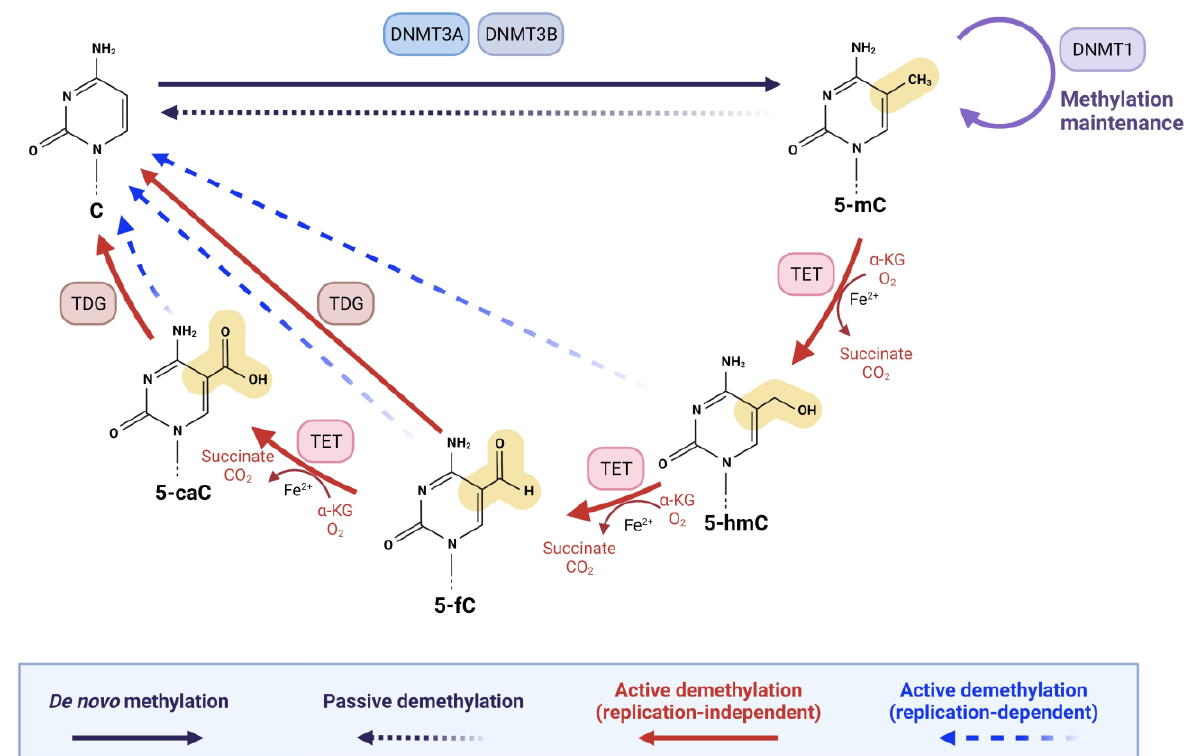
Figure 1. DNA demethylation in mammals. The two distinct mechanisms of erasure of 5-mC from the mammalian genome, also known as ‘DNA demethylation’, are shown. (1) In active demethylation, TET enzymes (TET1, TET2, and TET3) stepwise oxidize 5-mC to 5-hmC, 5-fC, and 5-caC. 5-fC and 5-caC are then excised by TDG and processed by BER, resulting in reversion of 5-mC to cytosine. Alternatively, replication-dependent dilution of 5-mC oxidation products takes place when 5-hmC, 5-fC, and 5-caC are reversed to unmodified cytosine during DNA replication (see Section 1.2 for detailed description). (2) In passive demethylation, failure of DNMTs function results in replacement of 5-mC by cytosine and dilution of 5-hmC content during DNA replication. 5-caC = 5-carboxylcytosin; 5-fC = 5-formylcytosine; 5-hmC = 5-hydroxymethylcytosine; 5-mC = 5-methylcytosine; α -KG = α -ketoglutarate; BER = base excision repair; C = cytosine; DNMT = DNA methyltransferase; TETs = ten-eleven translocation enzymes (TET1, TET2, and TET3); TDG = thymine DNA glycosylase. Figure was created using the software by BioRender (https: //biorender.com/, accessed on 8 February